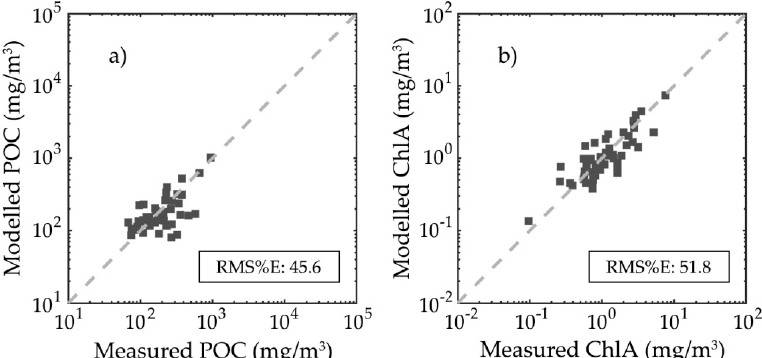
Figure 10. Comparison of ( a ) POC and ( b ) ChlA values as determined by the optimized models of Equations (13) and (14) vs. their respective measured values. The dashed grey lines indicate the 1:1 relationship.